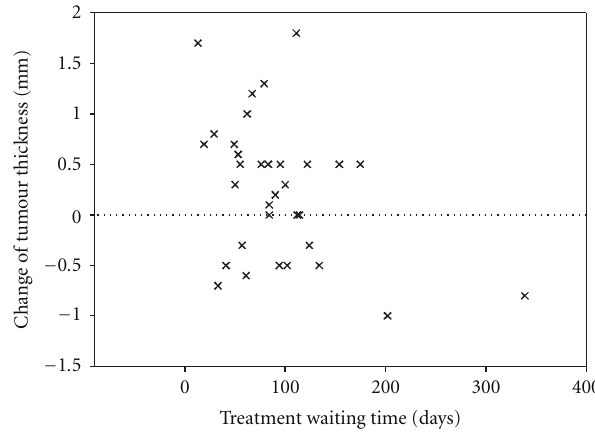
Figure 1: Scatter diagram showing changes of BCC thickness meas- urements from diagnosis to treatment. Reduction of thickness is indicated by positive